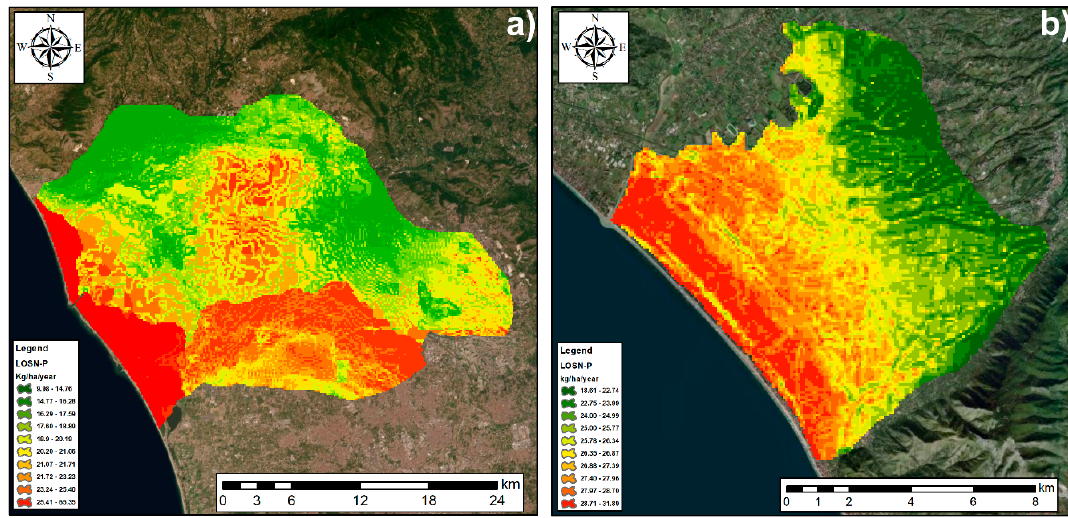
Figure 2 . LOSN-P application for a) the Campania plain and b) the Garigliano plain . 184 Figure 2. LOSN-P application for ( a ) the Campania plain and ( b ) the Garigliano